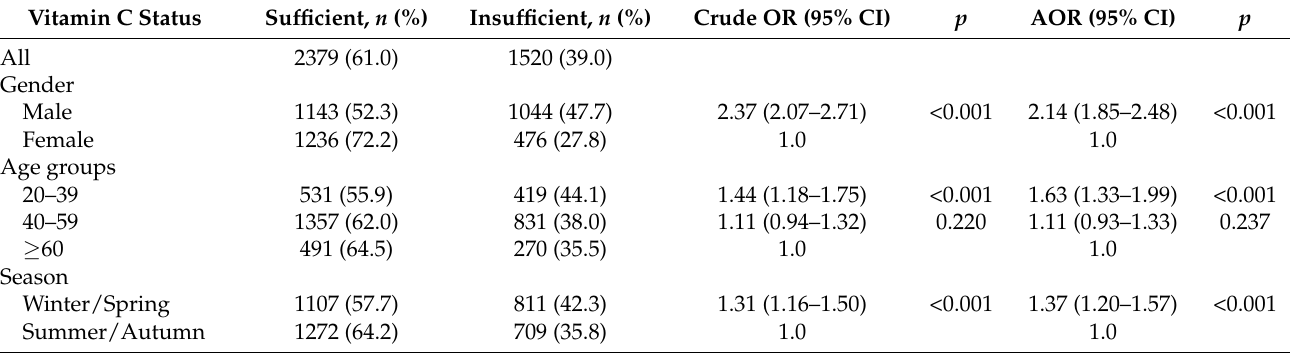
Table 2. Predictors for insufficient vitamin C levels (<50 µ mol/L, ≤ 8.8 mg/L) among all